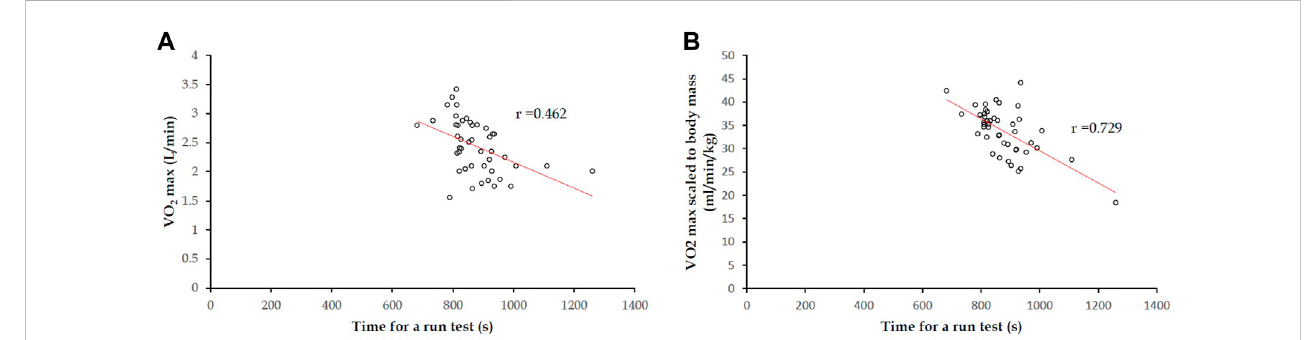
FIGURE 2 In45participants,forboth a3,000-m run fi eldtestandCPET: (A) correlationcoef fi cient oftime fora3,000-m run fi eldtestagainst VO 2 max(L/min) was 0.462 ( p = 0.001); (B) correlation coef fi cient of time for a 3,000-m run fi eld test with VO 2 max scaled to body mass (kg) was 0.729 ( p < 0.001).